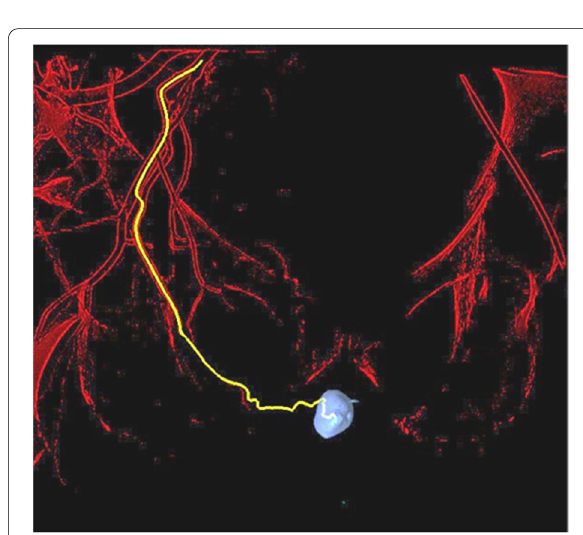
Fig. 3 The calculated roadmap can now be used as three-dimensional